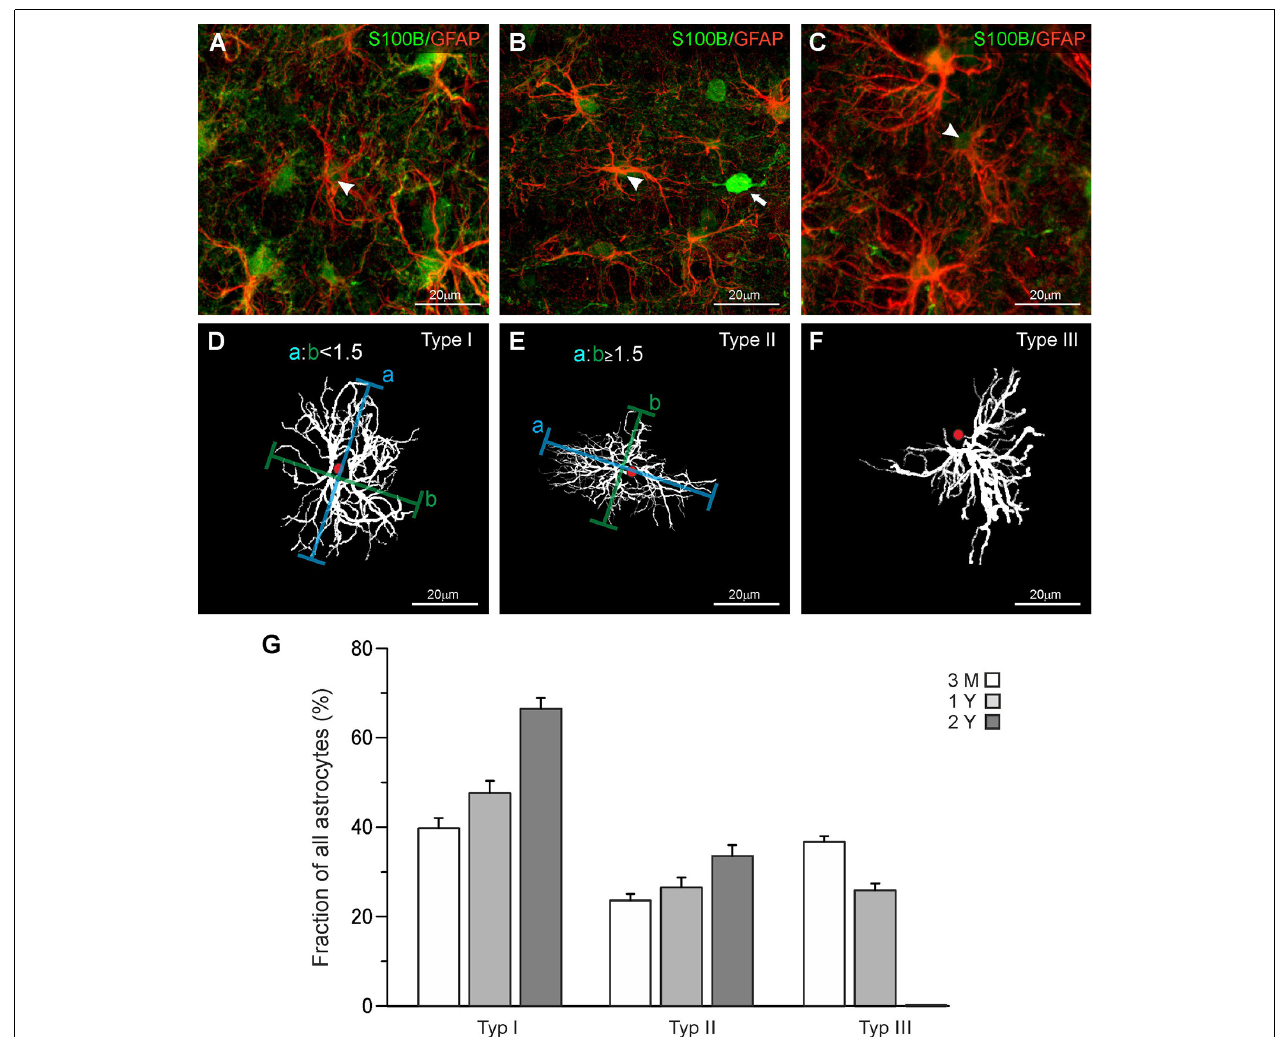
FIGURE 1 | Classification of astrocytes. (A–C) Anti-GFAP (red), and anti-S100B staining (green) of olfactory bulb astrocytes. Arrowheads point to astrocytes that have been traced and are depicted in panels (D–F) . (D) Astrocytes with a ratio of longitudinal-to-orthogonal extension of less than 1.5 were defined as stellate type I astrocytes. (E) Astrocytes with a ratio of longitudinal-to-orthogonal extension of 1.5 and more were defined as elliptic type II astrocytes. (F) Astrocytes with nearly all processes oriented unidirectionally were defined as “squid-like” type III astrocytes. (G) The fraction of type I astrocytes strongly increased between the age of 3 months and 2 years, while the fraction of type II astrocytes only weakly increased. Type III astrocytes decreased in number between 3 months and 1 year and disappeared